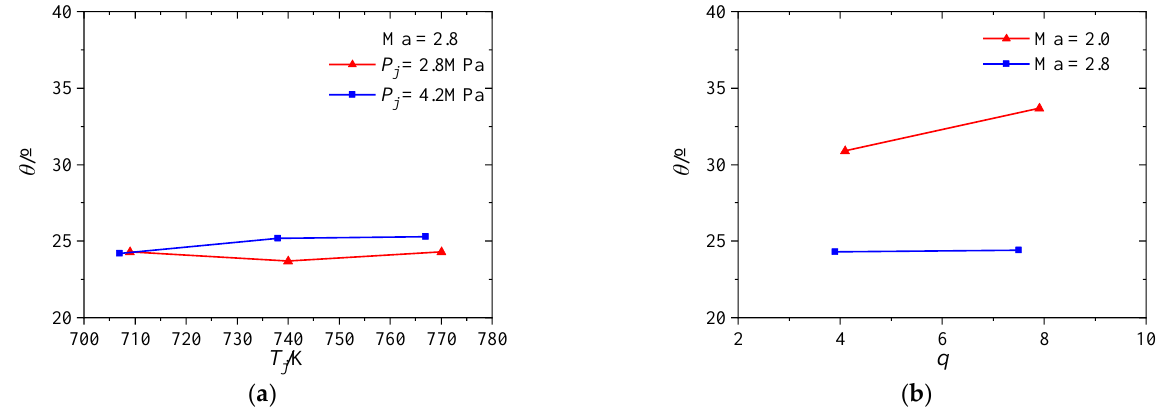
Figure 6. Comparison of shock structure: ( a ) schlieren visualization, ( b ) numerical schlieren.